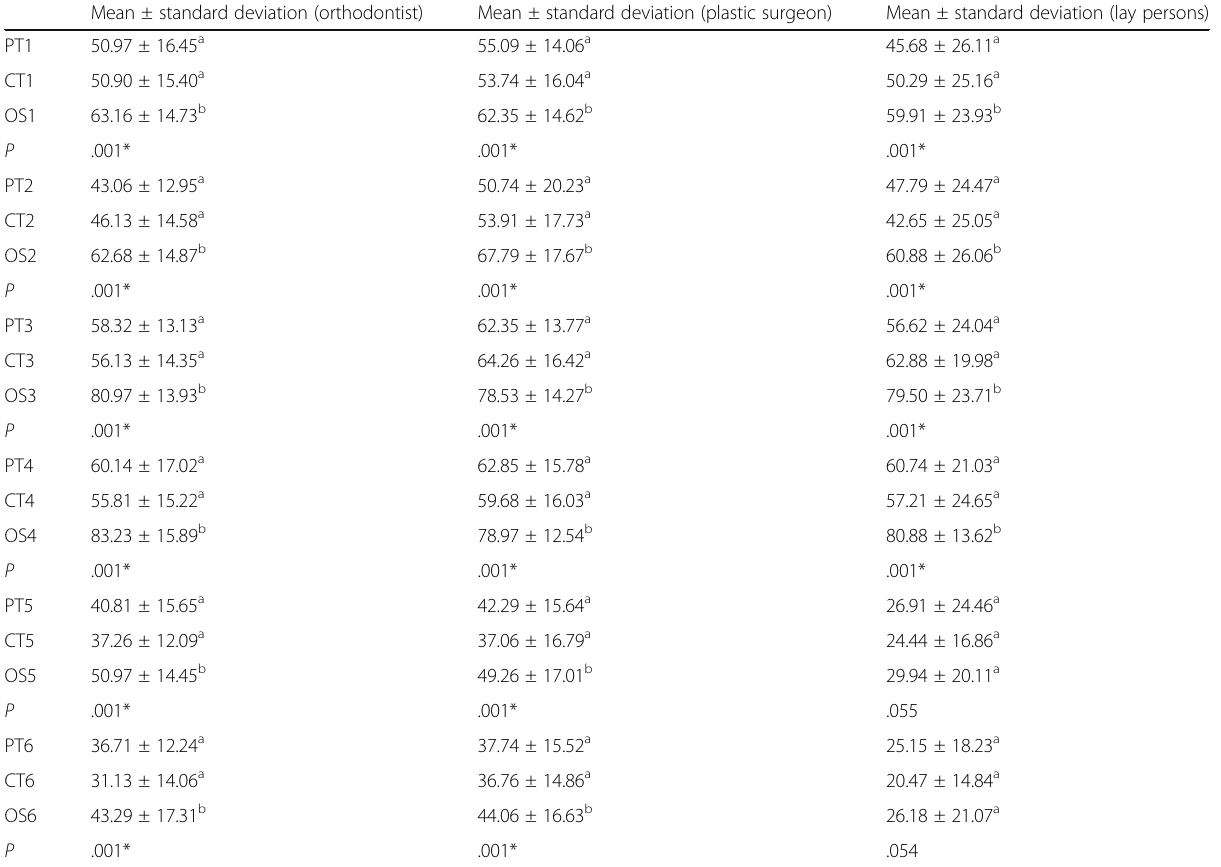
Table 4 Intra-group comparison of profiles according to nose types Mean ± standard deviation (orthodontist) Mean ± standard deviation (plastic